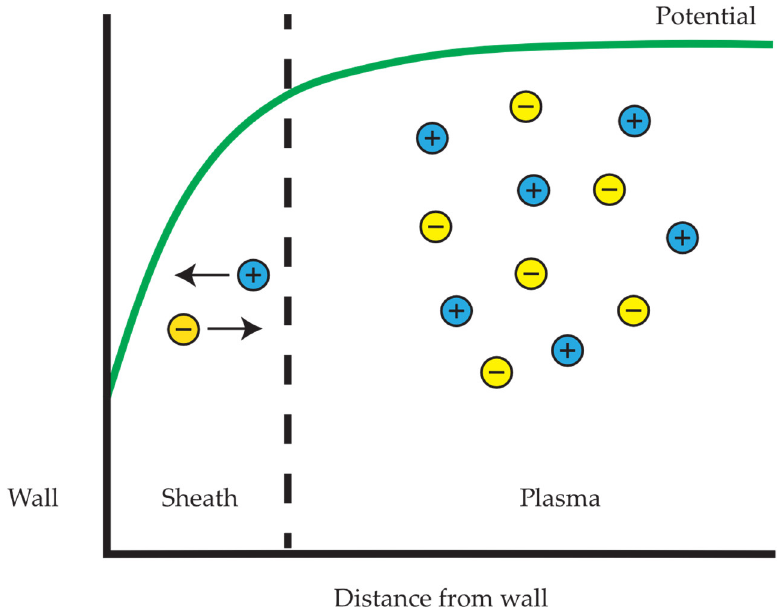
Figure 3. Simplified illustration of the potential drop in the wall sheath [24]. The potential gradient in the sheath repels electrons (yellow) away from the wall and accelerates ions (blue) toward the wall.